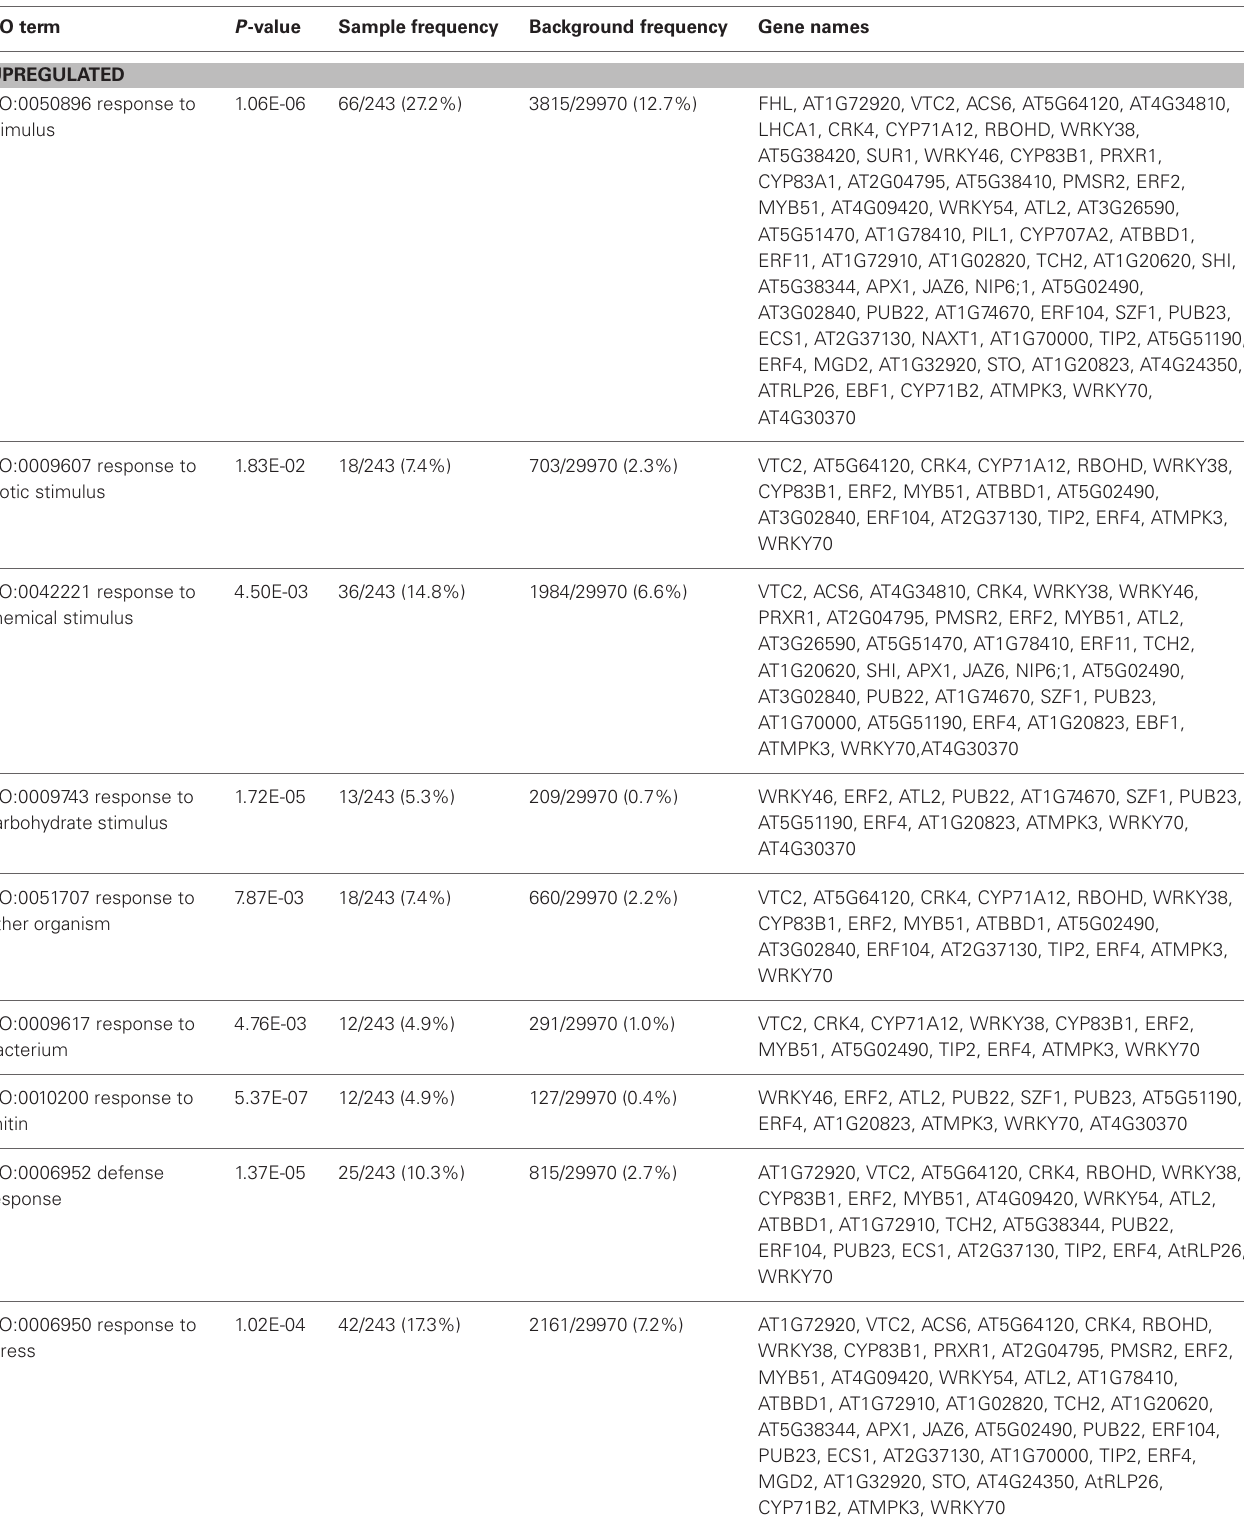
Table 1 | Identification of Gene Ontology (GO) functional categories that are enriched in transcript populations in shoots ( n = 3) in the presence of whole soil microbial